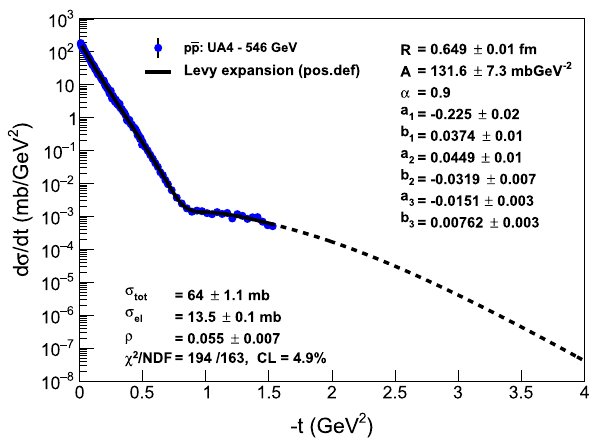
Fig. 26 Third-order Lévy expansion fits of the differential cross- section data on p ¯ p elastic scattering at fixed α = 0 . 9